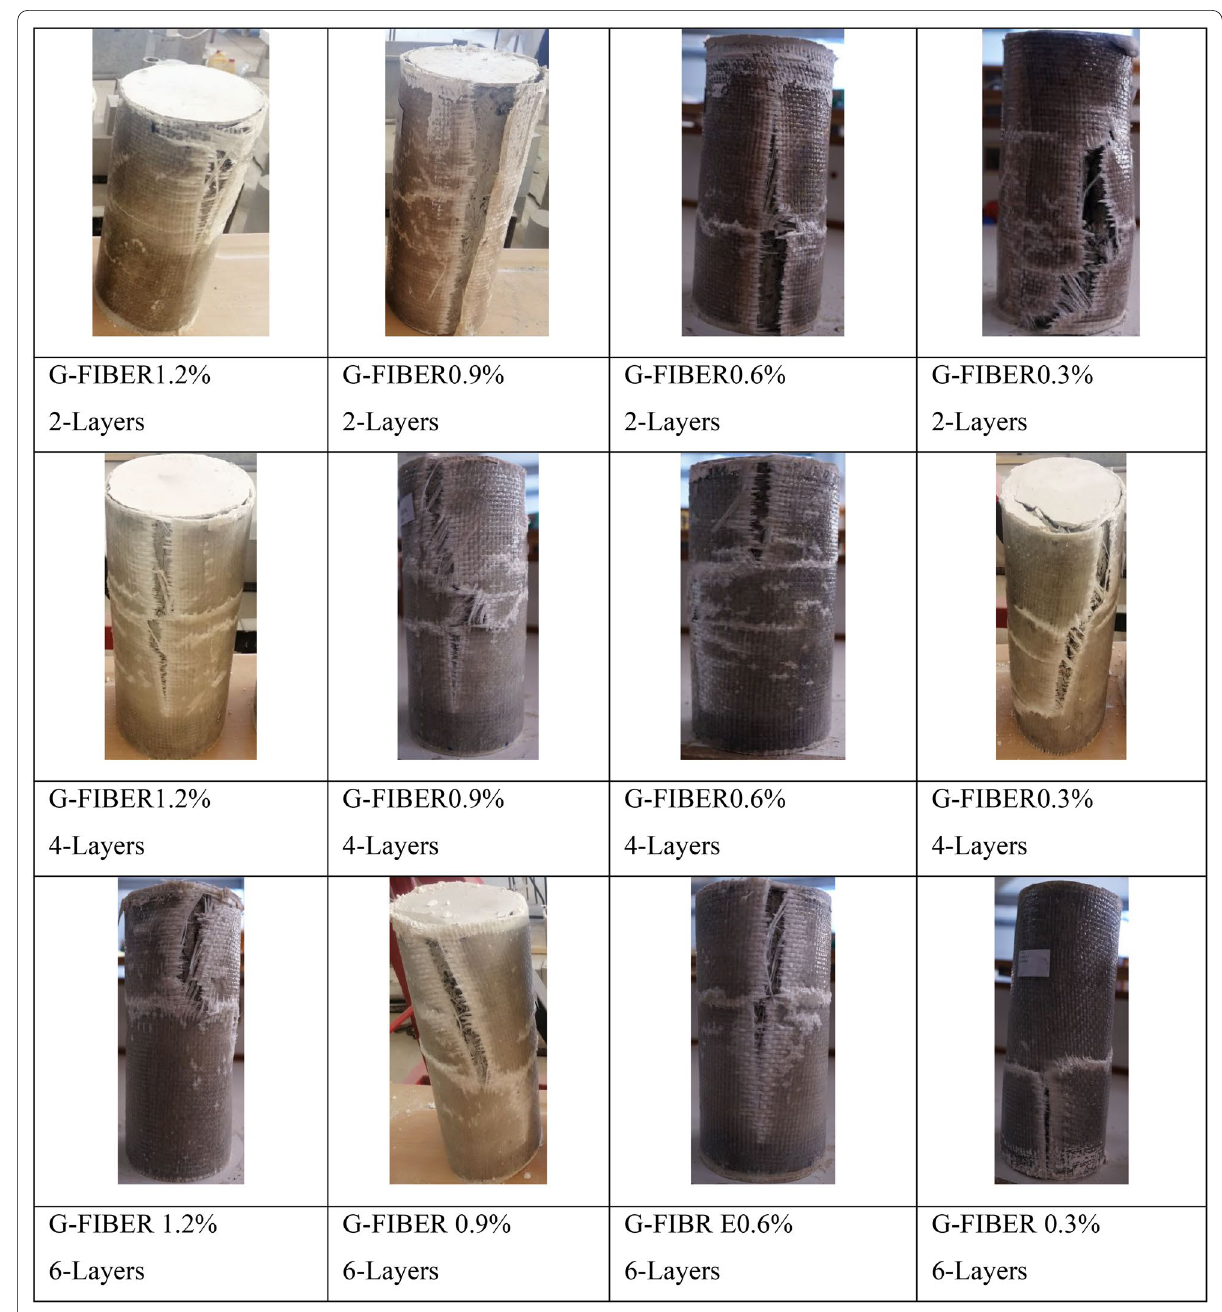
Fig. 7 Typical failure modes of test cylinders (strength concrete